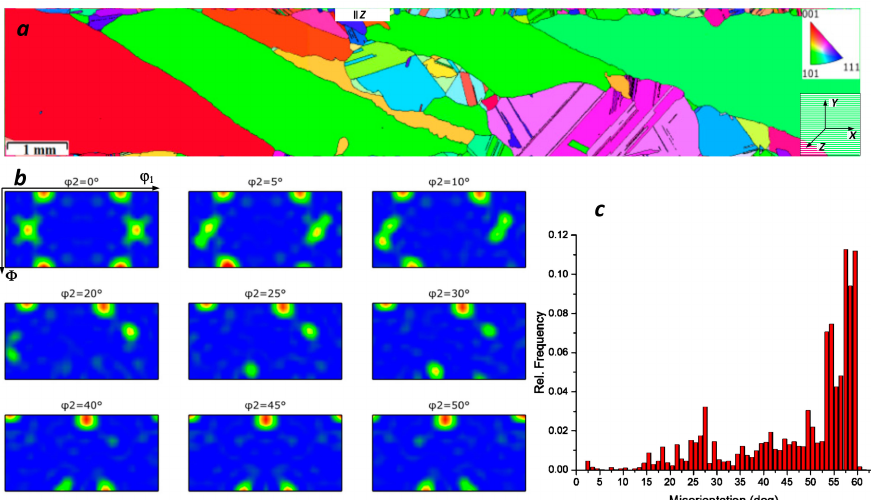
Figure 9. Grain orientation map ( a ), ODF ( b ) and grain boundary misorientation angle distribution ( c ) for sample